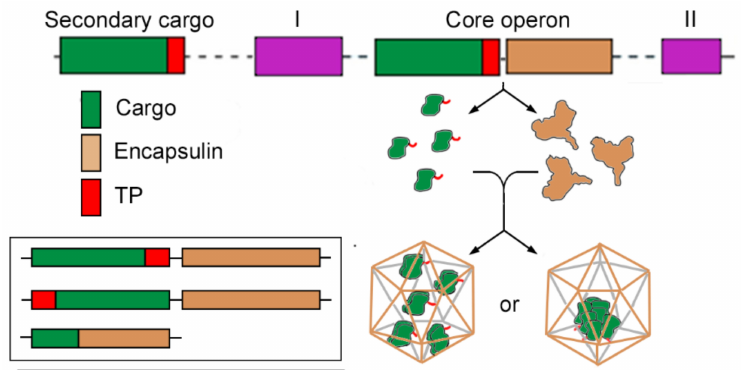
Figure 1. Organization of the encapsulin system. The core operon includes two genes, a cargo gene (green) and an encapsulin gene (orange). The targeting peptide (TP, red) is at the cargo C-terminus, but could be located at the N-terminus or be absent (inset). Other components associated to the operon without TP are indicated as I and II (purple). Secondary cargos are not included in the core operon but contain a TP. The cargo monomers are encapsulated as small oligomers at a high copy number ( left ) or associated into one or two large oligomers ( right